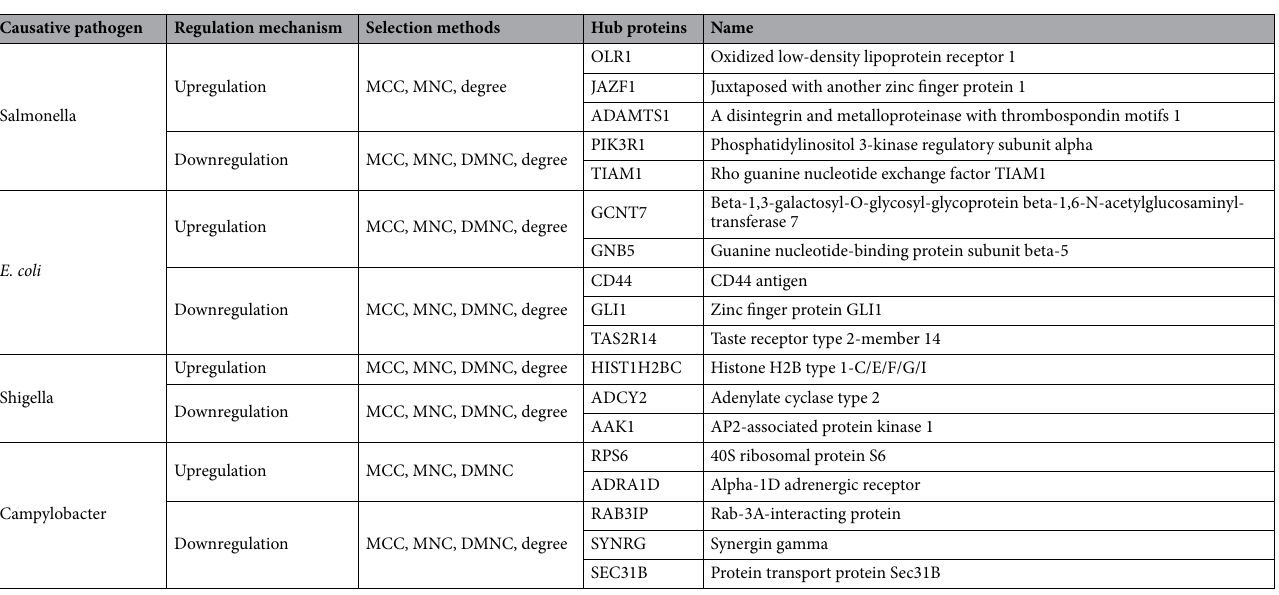
Table 2. The name and selection methods of the potential